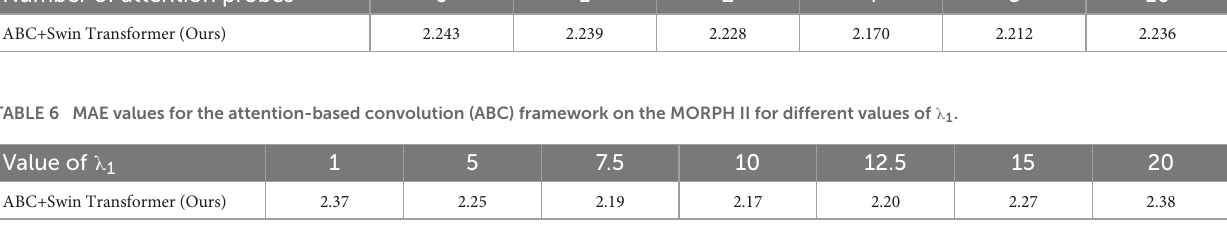
TABLE 5 MAE values for the attention-based convolution (ABC) framework on the MORPH Album II dataset for different numbers of attention probes. Number of attention probes